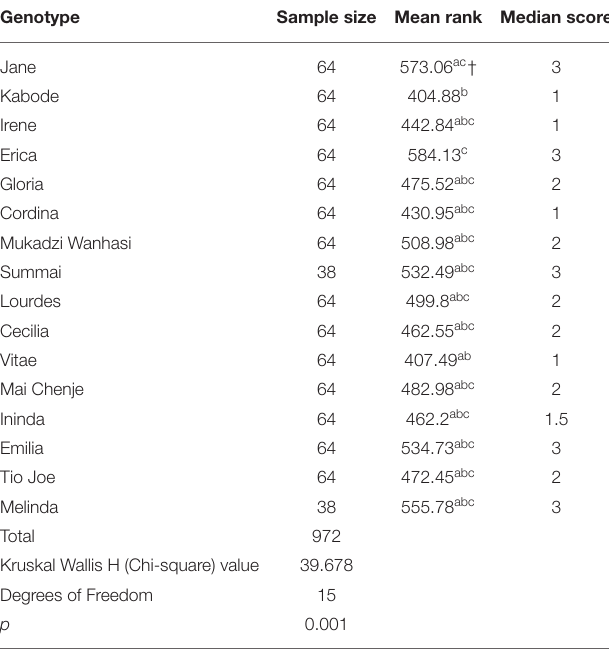
TABLE 4 | Taste mean ranks and median scores of farmers across Njelele 1, Njelele 2, and Njelele 3.